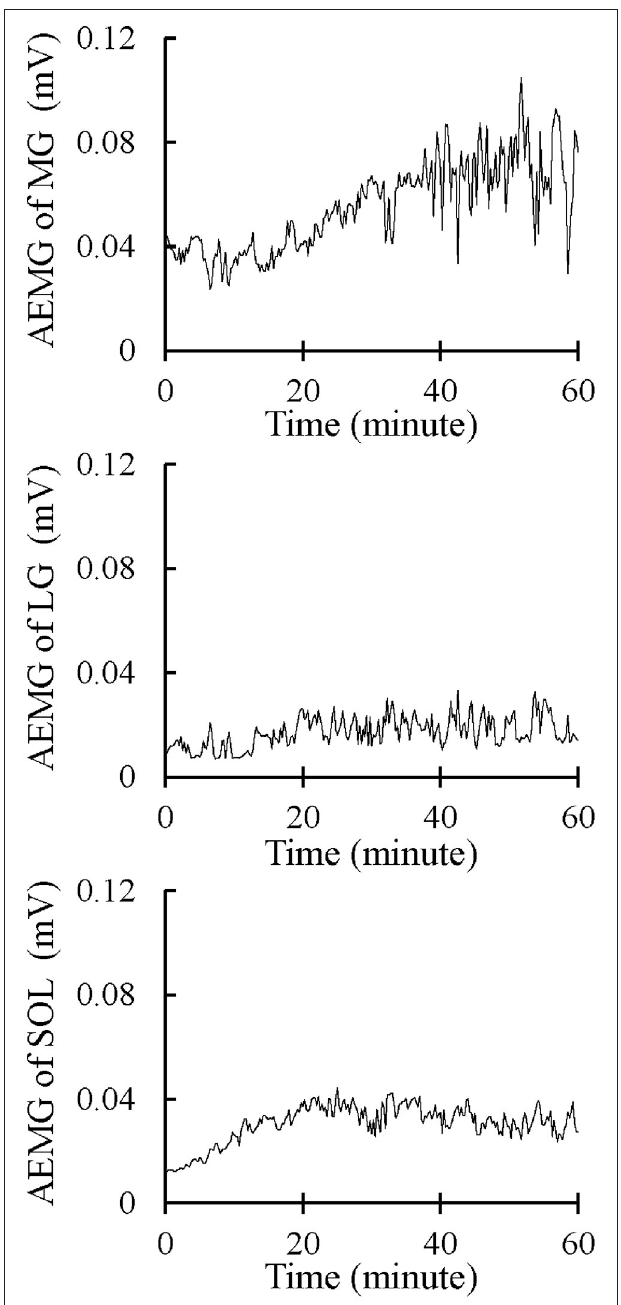
FIGURE 3 | Typical images of the 15-s averaged electromyography signals (AEMG) of the medial and lateral gastrocnemius muscles (MG and LG) and the soleus muscle (SOL) during the 1-h fatiguing